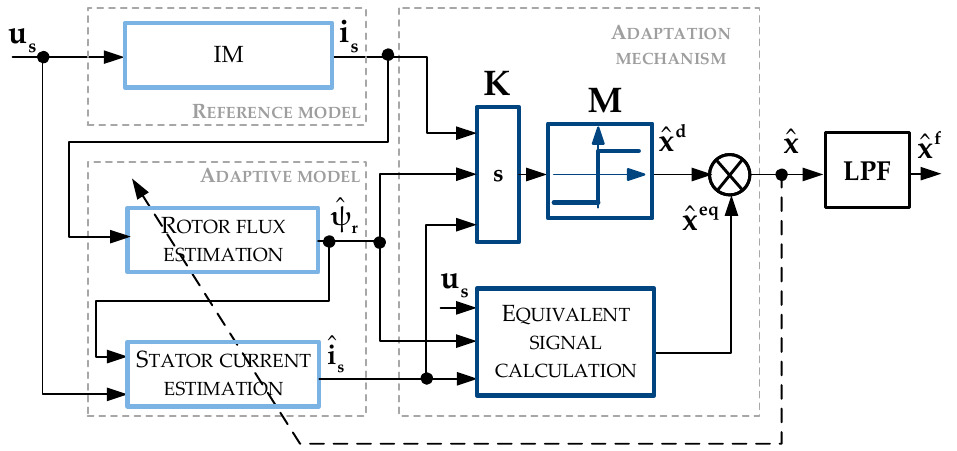
Figure 1. Block diagram of the applied speed estimator Eq-SMMRAS CC [27]. IM: induction motor, LPF: low pass filter.